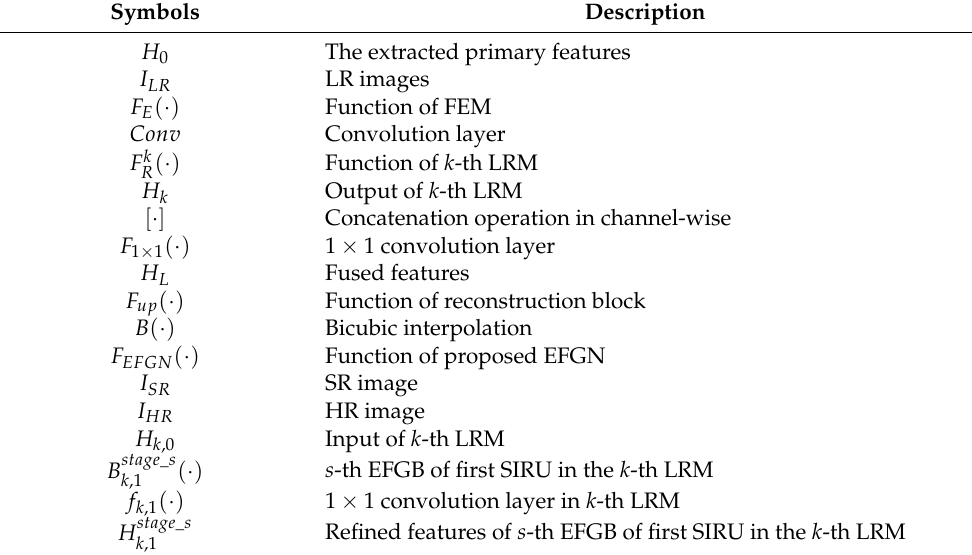
Table 1. Concise description of symbols in the